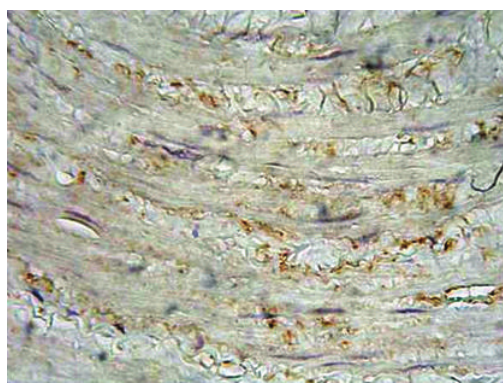
Figure 6: Discontinuous, weak eNOS cytoplasmatic expression in the endothelial lining of the varicose vein sample (magnification 630x, DAB).